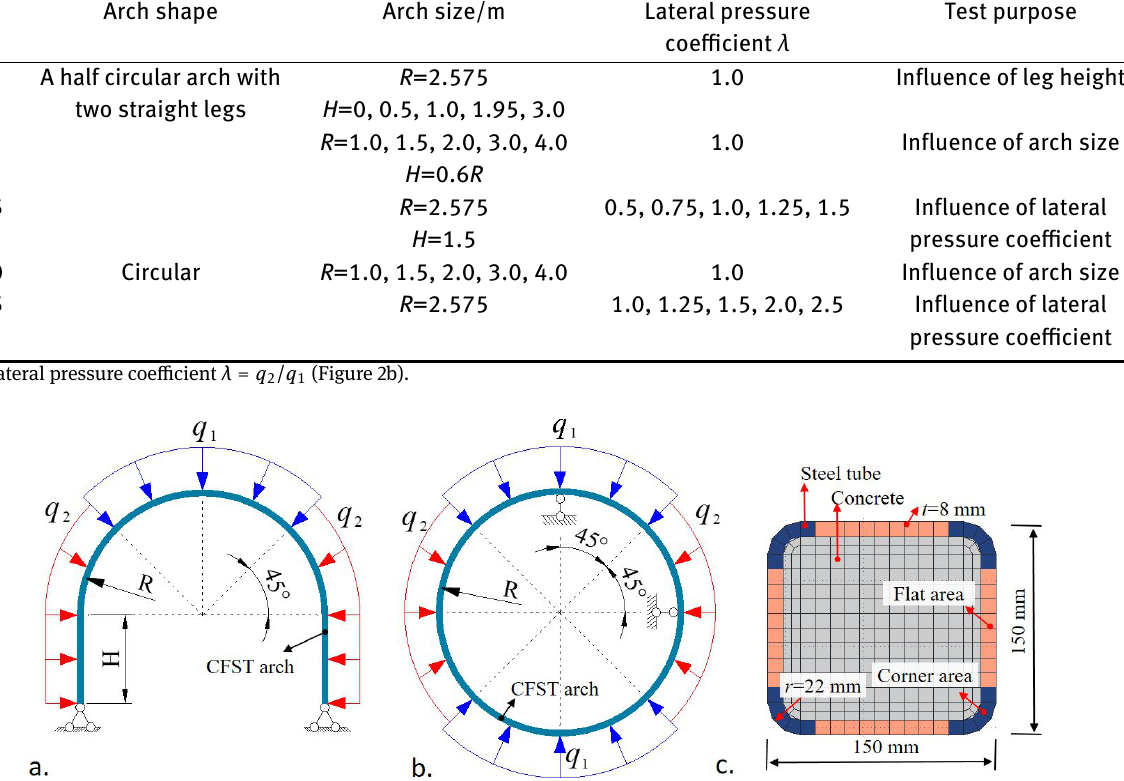
Figure 2: Models of the tested CFST supporting arch. (a) straight-leg arch; (b) circular arch; (c) cross-section of the